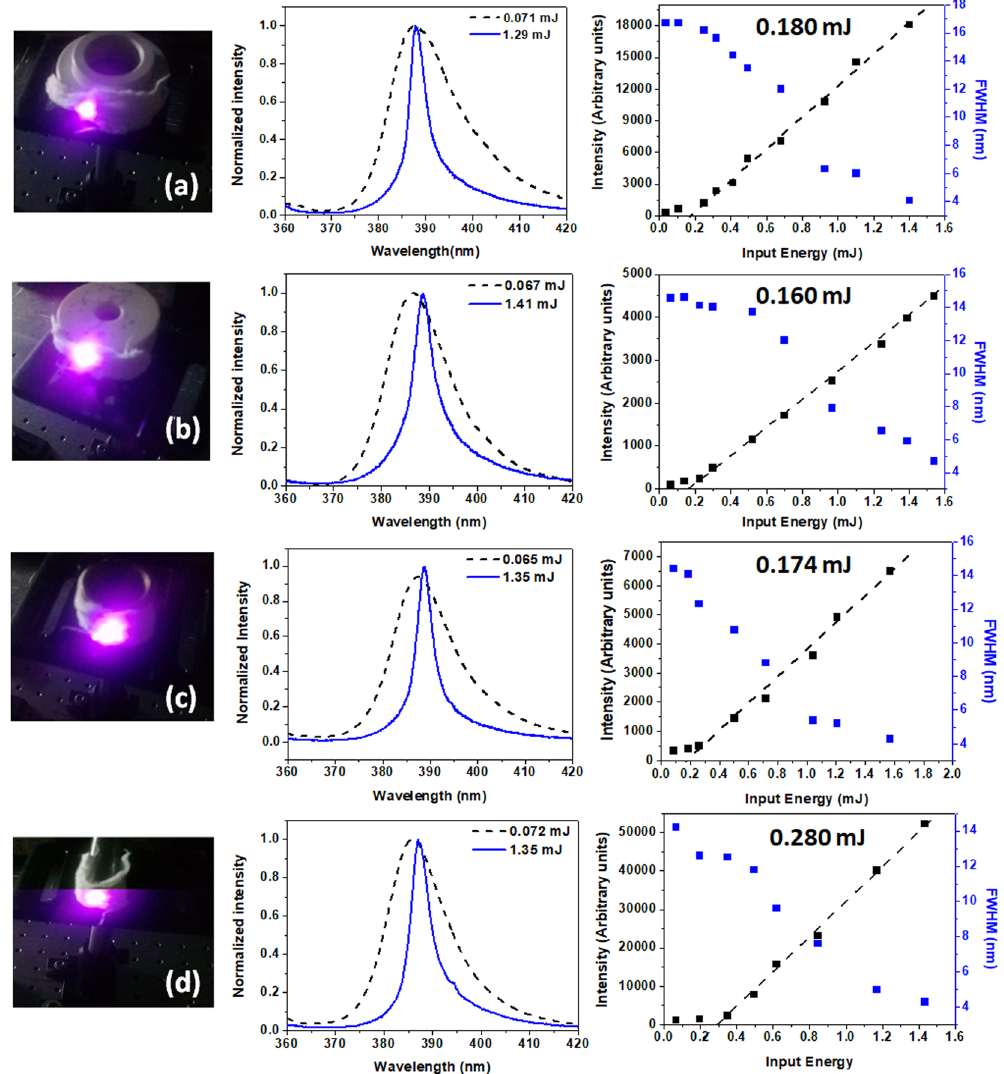
Figure 8. Normalized intensity vs. input energy and corresponding variation in intensity/FWHM measured at different bending radius of electrospun fibers (curvature of 0.22 cm − 1 ( a ), 0.25 cm − 1 ( b ), 0.40 cm − 1 ( c ) and 0.83 cm − 1 ( d )). The pictures show the excitation laser position on the